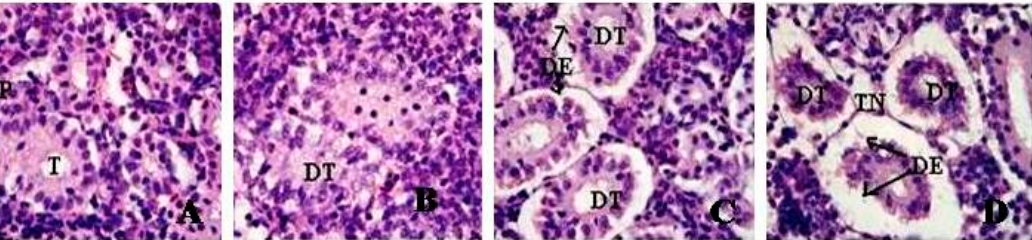
Figure 12. Histopathological Characterization (H&E Staining 1000 X) of Kidneys in Sprague-Dawley rats exposed to graphene oxide (GOs). ( A ) Negative Control Deionized water (T = tubule); ( B ) 10 mg/Kg exposed kidney (DT = dilated tubule, HP = Hematopoetic tissue); ( C ) 20 mg/K (DT =dilated tubule, DE = degeneration of epithelial cells); ( D ) 40 mg/Kg (DT = dilated tubule, DE = degeneration of epithelial cells, TN = Tubular necrosis).